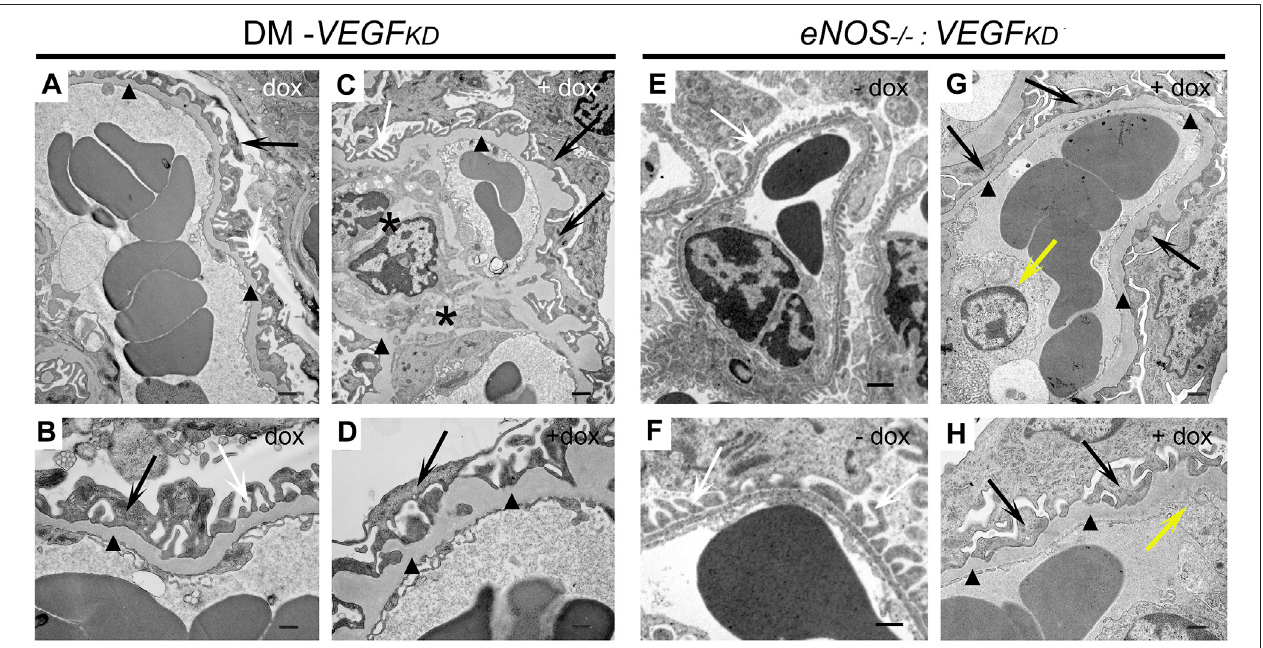
FIGURE 3 | Effect of VEGF KD on glomerular ultrastructure of diabetic and eNOS − / − : VEGF KD kidneys. Representative TEM images: (A,B) diabetic control (DM- VEGF KD ( − dox) glomerular capillary loop shows GBM thickening (black arrowheads) and partial foot process effacement (FPE: black arrows, normal FP: white arrows); (C,D) diabetic VEGF KD (+ dox) glomerulus shows mesangial sclerosis (black asterisks), extensive FPE (black arrows) and GBM thickening (black arrowheads); (E,F) eNOS − / − :VEGF KD ( − dox) glomerulus shows preserved fi ltration barrier ultrastructure; (G,H) eNOS − / − :VEGF KD (+dox) glomerulus shows massive FPE (black arrows), GBM thickening (black arrowheads) and endotheliosis (yellow arrows). Scale bars: 1 μ m in top images (A,C,E,G) ; 500 nm in bottom images (B,D,F,H) ; + dox: VEGF KD induction with